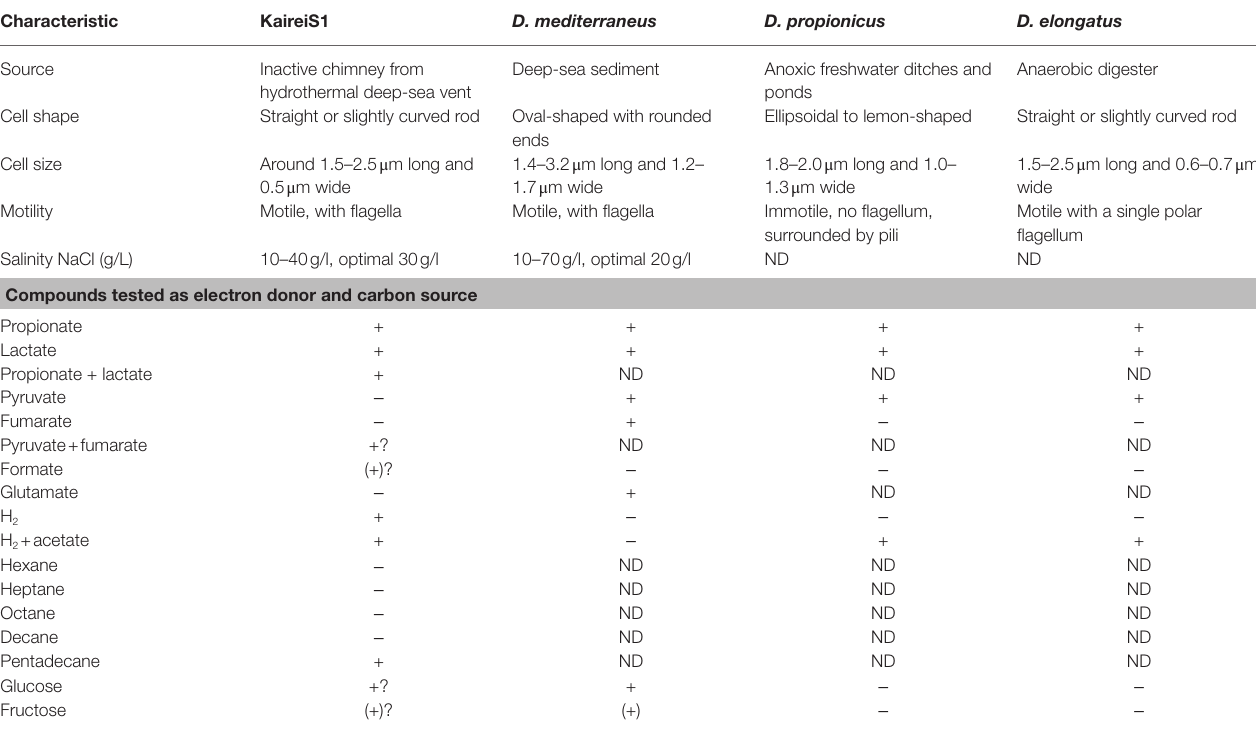
TABLE 2 | Characteristics of Strain KaireiS1 compared to those of three of the closest cultured relatives Desulfobulbus mediterraneus (Sass et al., 2002), Desulfobulbus propionicus (Widdel and Pfennig, 1982), and Desulfobulbus elongatus (Samain et al., 1984).